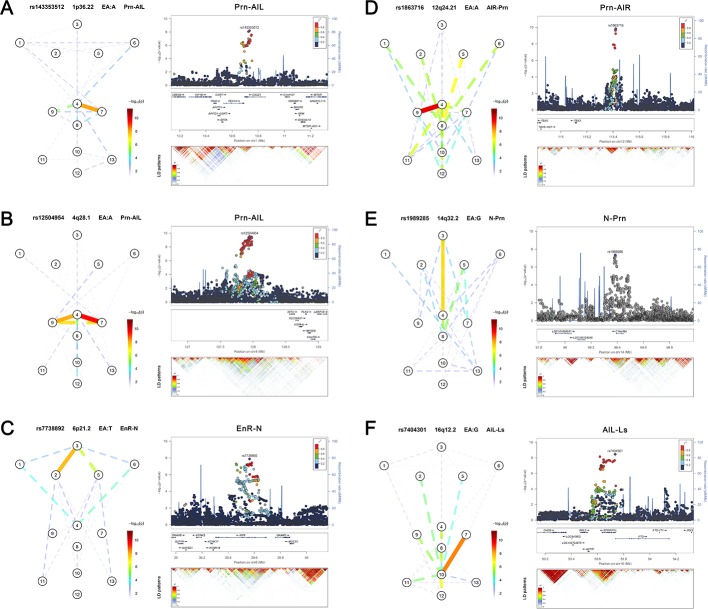
Six novel genetic loci associated with facial shape phenotypes and successfully replicated.The figure is composed by six parts, (A) 1p36.22 CASZ1 region, (B) 4q28.1 INTU region, (C) 6p21.2 KIF6 region, (D) 12q24.21 TBX3 region, (E) 14q32.2 C14orf64 region, and (F) 16q12.2 RPGRIP1L region. Each part includes two figures, Face map (left) denoting all of the top-SNP-associated phenotypes weighted by the statistical significance (-log10P). The dashed line means that the P value was nominally significant (p<0.01) but did not reach study-wide suggestive significance (p>5e-8). LocusZoom (right) shows regional association plots for the top-associated facial phenotypes with candidate genes aligned below according to the chromosomal positions (GRCh37.p13) followed by linkage disequilibrium (LD) patterns (r2) of EUR in the corresponding regions. Similar figures for all 24 study-wide suggestively significant loci are provided in Figure 2—figure supplements 1–24.